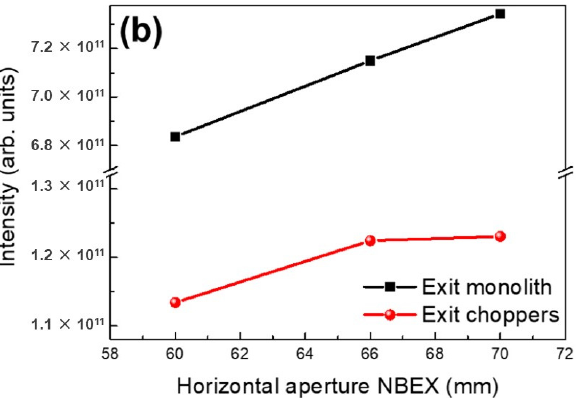
Figure 2. ( a ) Horizontal view of the moderator adapted from Ref. [18]; ( b ) Integrated intensity monitored at the exit of the NBEX and the end of the curved guide for several widths: 60 mm, 66 mm and 70 mm.